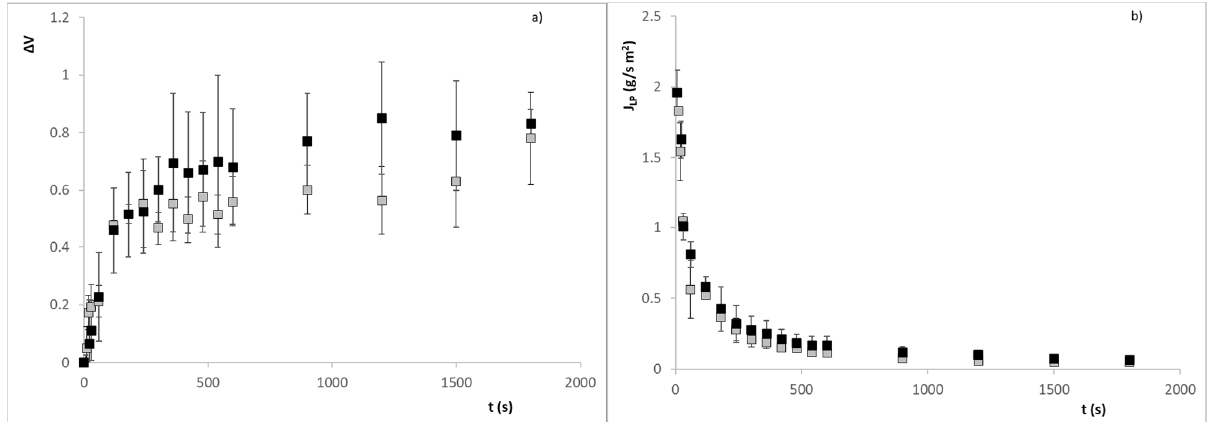
Figure 6. ( a ) Evolution of the volume variation of alginate beads with iron ion; ( b ) Evolution of the LP flux entering the calcium alginate beads with iron ion. Symbol ■ refers to pH = 3 and ■ refers to pH = 4.7.